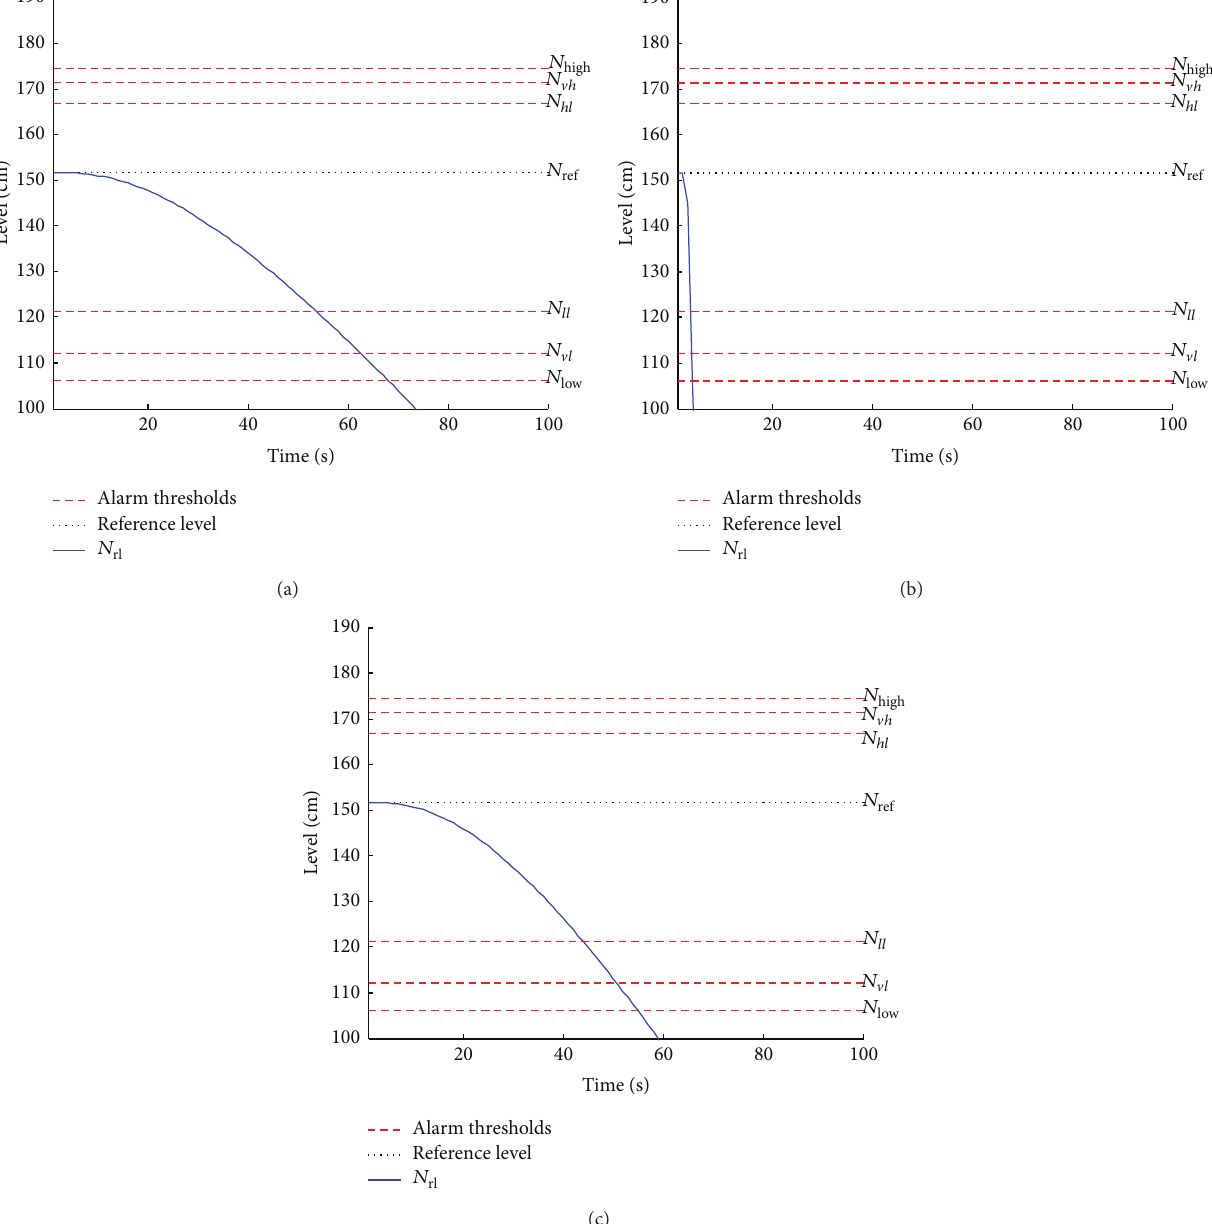
= 50.5 (kg/s) and the communication fails; (b) the sf